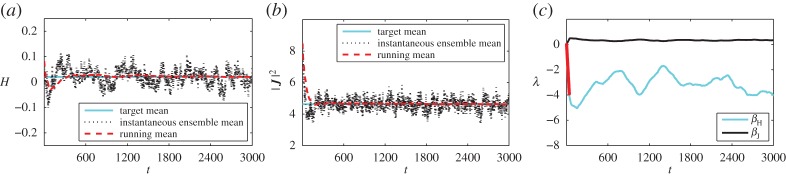
Results when using long-time mean observations as a target while adaptively determining the Lagrange multipliers. Target observations for Hamiltonian (a) and momentum magnitude (b) are overlaid with the instantaneous ensemble mean (black dotted line)and the running ensemble mean (red solid line) from simulation. (c) Lagrange multipliers, the red dots indicate time steps at which their rate of change was limited. (Online version in colour.)